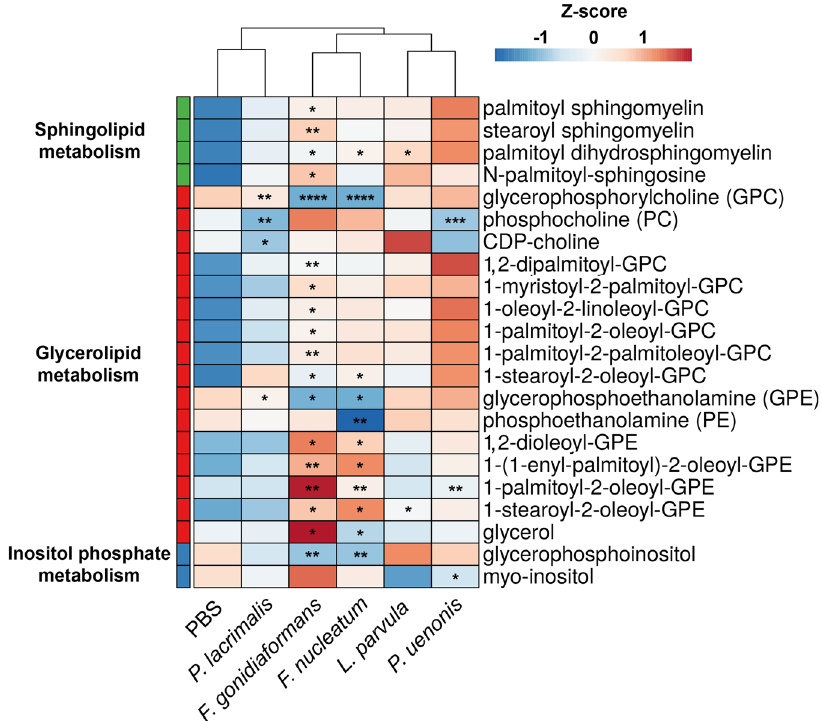
Fig. 8 Fusobacterium spp. modulate glycerolipid and sphingolipid metabolism during 3-D cervical cell infection. Heatmap of extracellular sphingolipids, glycerolipids, and inositol phosphate metabolites differentially regulated by infection with BVAB. Metabolite intensity values were log-transformed, autoscaled, and row-centered prior to hierarchical clustering analysis using Euclidean distance measures and average linkage clustering algorithms. Asterisks indicate statistically different metabolites between infectious treatments and mock-infected controls. Only lipid species signi fi cantly different between at least on BVAB species and mock-infected controls are shown. * p < 0.05; ** p < 0.01; *** p < 0.001; **** p < 0.0001. Two-tailed paired Student ’ s t - tests. A minimum of n = 3 independent replicates were performed and measured for each